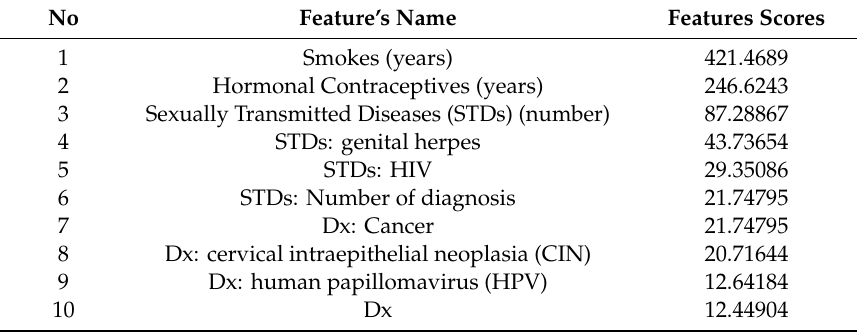
Table 4. Results of